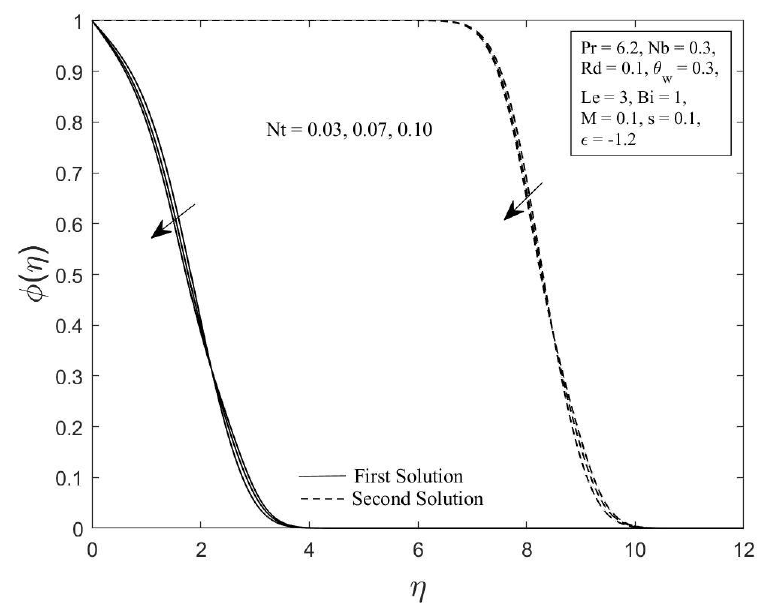
Figure 9. The concentration profile 𝜑(𝜂) for diverse values of 𝑁𝑡 .